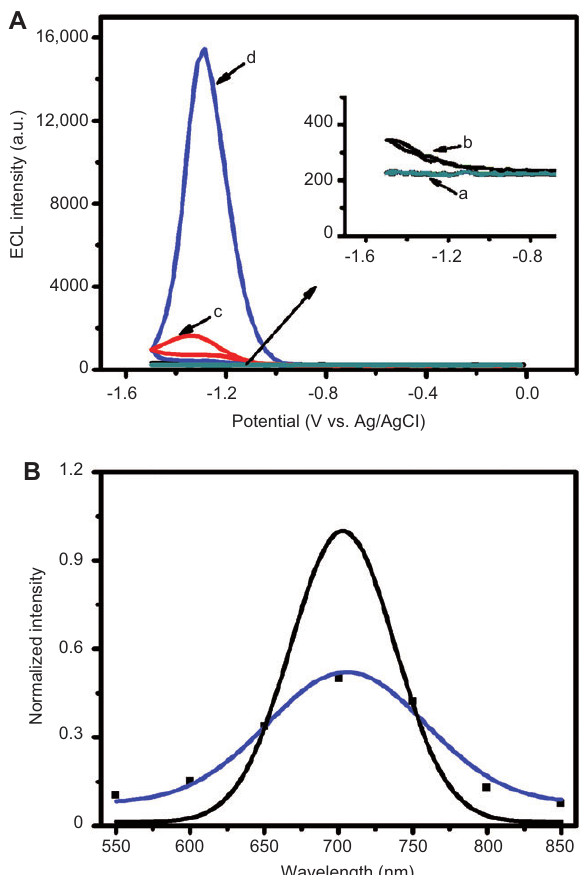
Figure 3 (A) ECL-potential curves of (a) CdTe/CdS/ZnS QDs, (b) 10 m m K (d) CdTe/CdS/ZnS QDs with 10 m m K solution (pH 7.0). (B) ECL (square) and PL (line) spectra of